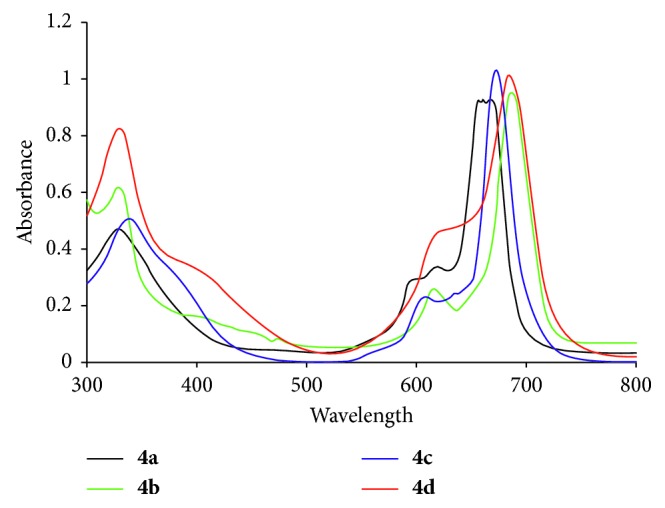
The absorption spectra of (qz)4NiPcs 4a–d in DMF.